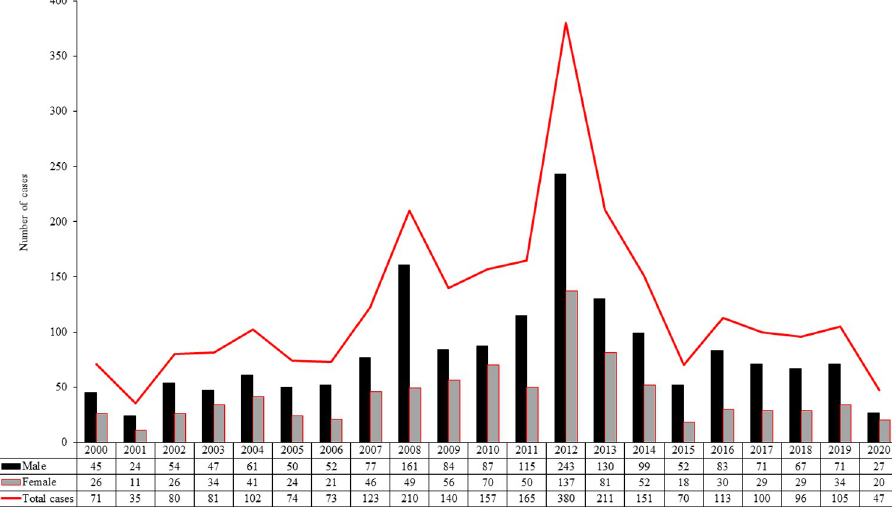
Fig 3. Number of cases of leptospirosis by year and sex (2000–2020). In the figure, the number of cases is plotted on the ordinate as a function of the years on the abscissa for males (black bars), females (gray bars), and the total (red line). The box with the key to the colors at the lower left also marks the respective data for each year in the two rows underneath the abscissa